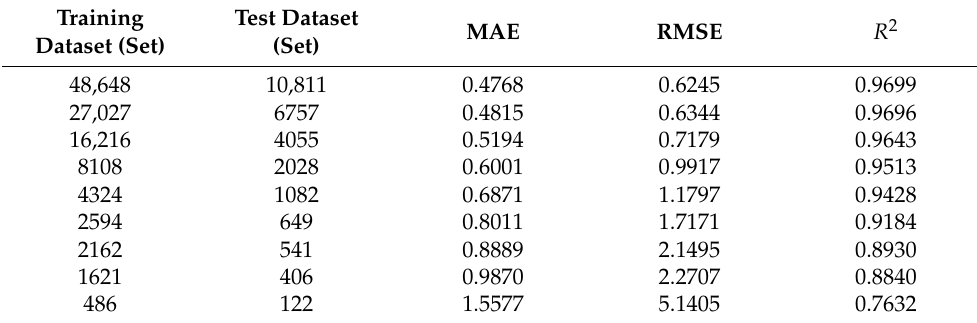
Table 4. Comparison of evaluation indicators of the proposed models with different sizes of dataset on unseen test